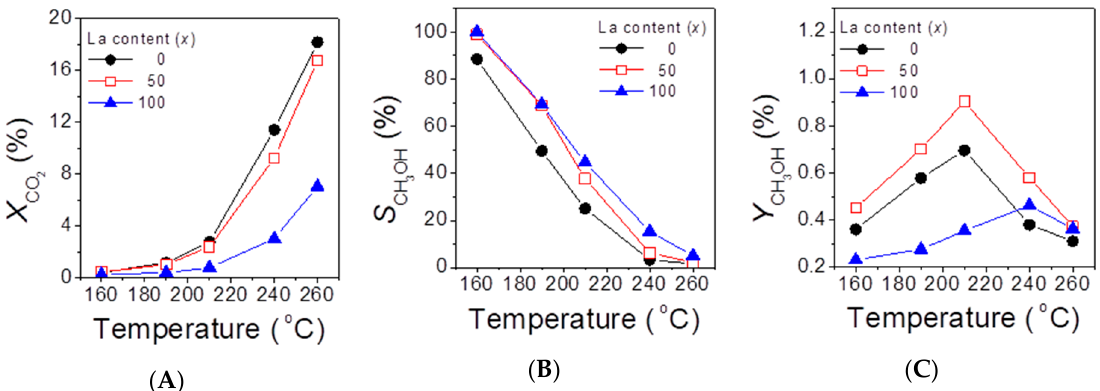
Figure 3. ( A ) Conversion of CO 2 , ( B ) selectivity to methanol, and ( C ) yield of methanol as functions of the reaction temperature obtained over CZA-La x catalysts with x = 0, 50, or 100. Experimental conditions: mass of catalyst: 200 mg; total flow rate: 50 cm 3 min − 1 ; feed composition: 10% CO 2 and 90% H 2 .